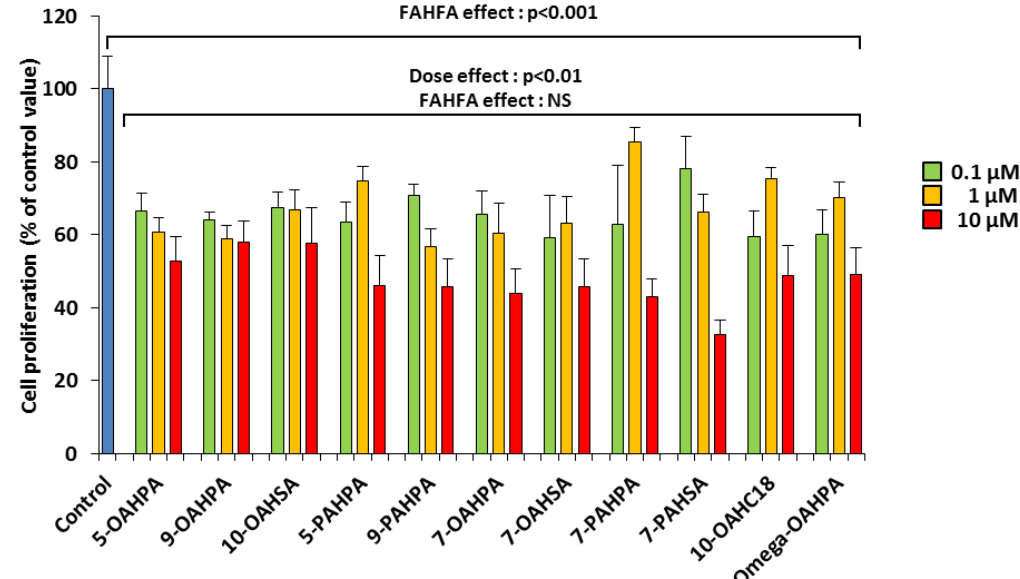
Figure 2. FAHFAs decreased C2C12 myoblast proliferation. Cell proliferation was measured by total DNA quantification using QuantiFluor 24 h after FAHFA treatment at the indicated concentration ( n = 6 for each group). The effect on the groups, including the control group, was tested by one-way ANOVA, followed up by a Fisher’s least significant difference (LSD) test; all the groups, except the control group, were also tested for the effects of dose, FAHFAs, and their interaction by two-way ANOVA test. Results are expressed as means ± SEM.